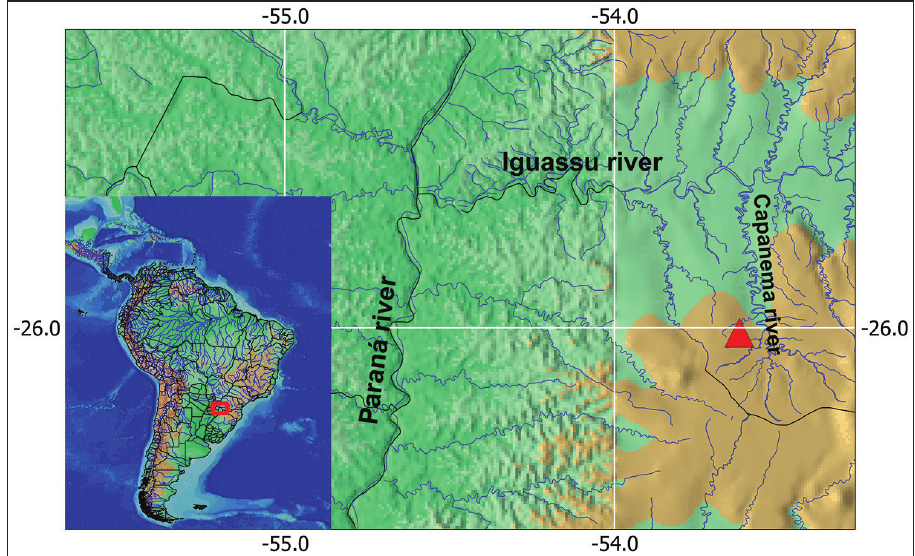
Figure 1. Localization of Florido River from the Iguassu River basin, where Corydoras carlae individuals were captured. Red triangle indicates the sampled